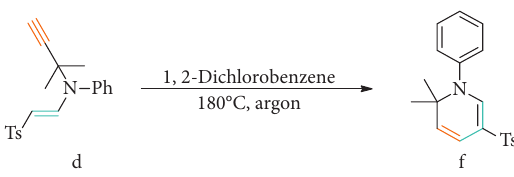
Scheme 2: Metal-free propargyl aza-Cope